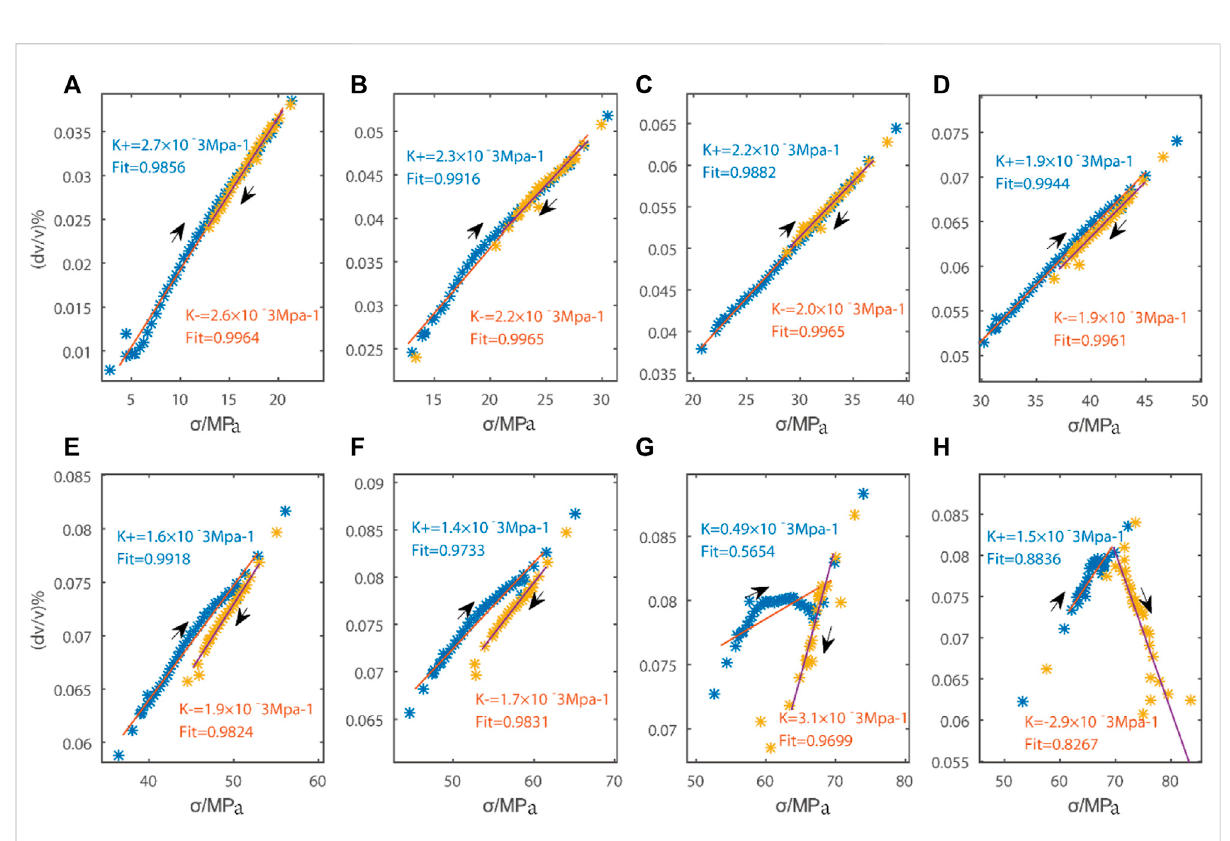
FIGURE 10 Rate of change of direct wave velocity in each loading and unloading stage (A – H)